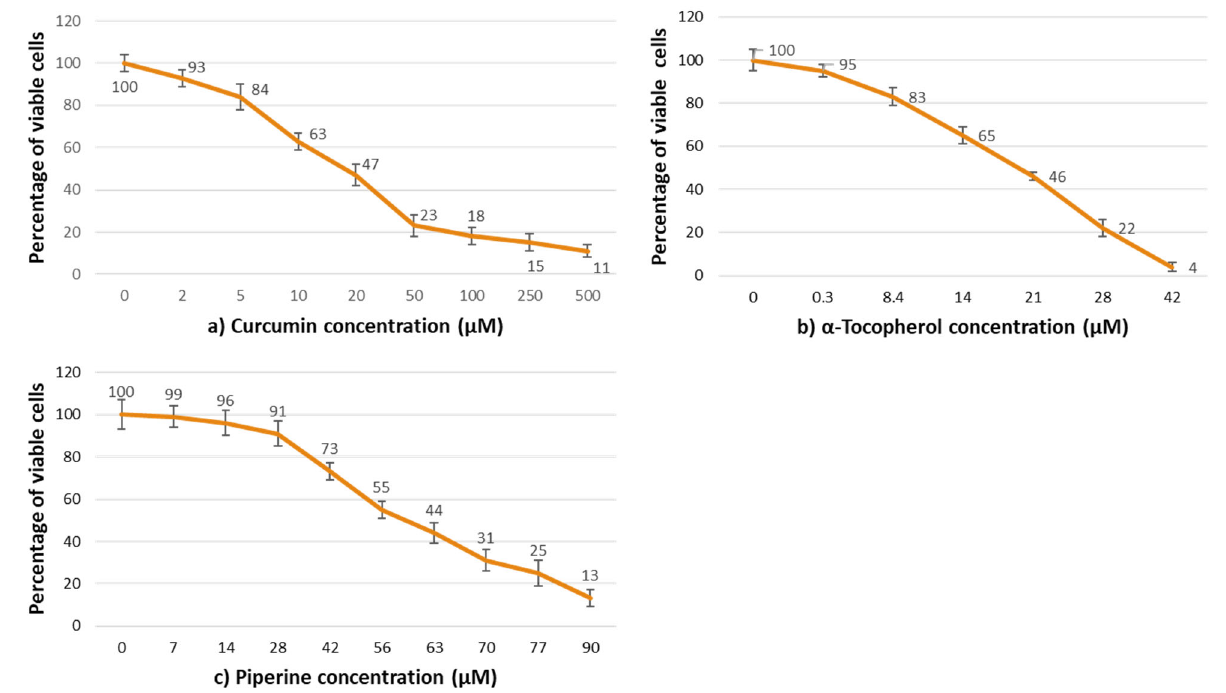
Figure 3. Percentage of viable fibroblasts NIH3T3 after 24 h of contact with different concentrations of: ( a ) Curcumin; ( b ) α -Tocopherol; ( c ) Piperine.